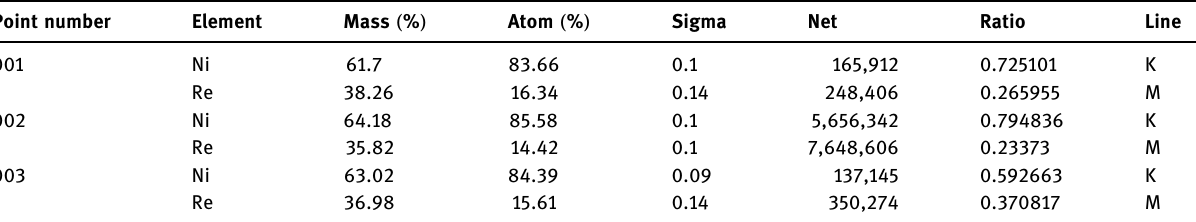
Table 1: Chemical composition of the Ni – 37Re coating ( j = 25 mA · cm − 2 , 5 g · L − 1 of ammonium rhenate ( VII ) in the bath of the alloy coating ) in the three di ff erent points